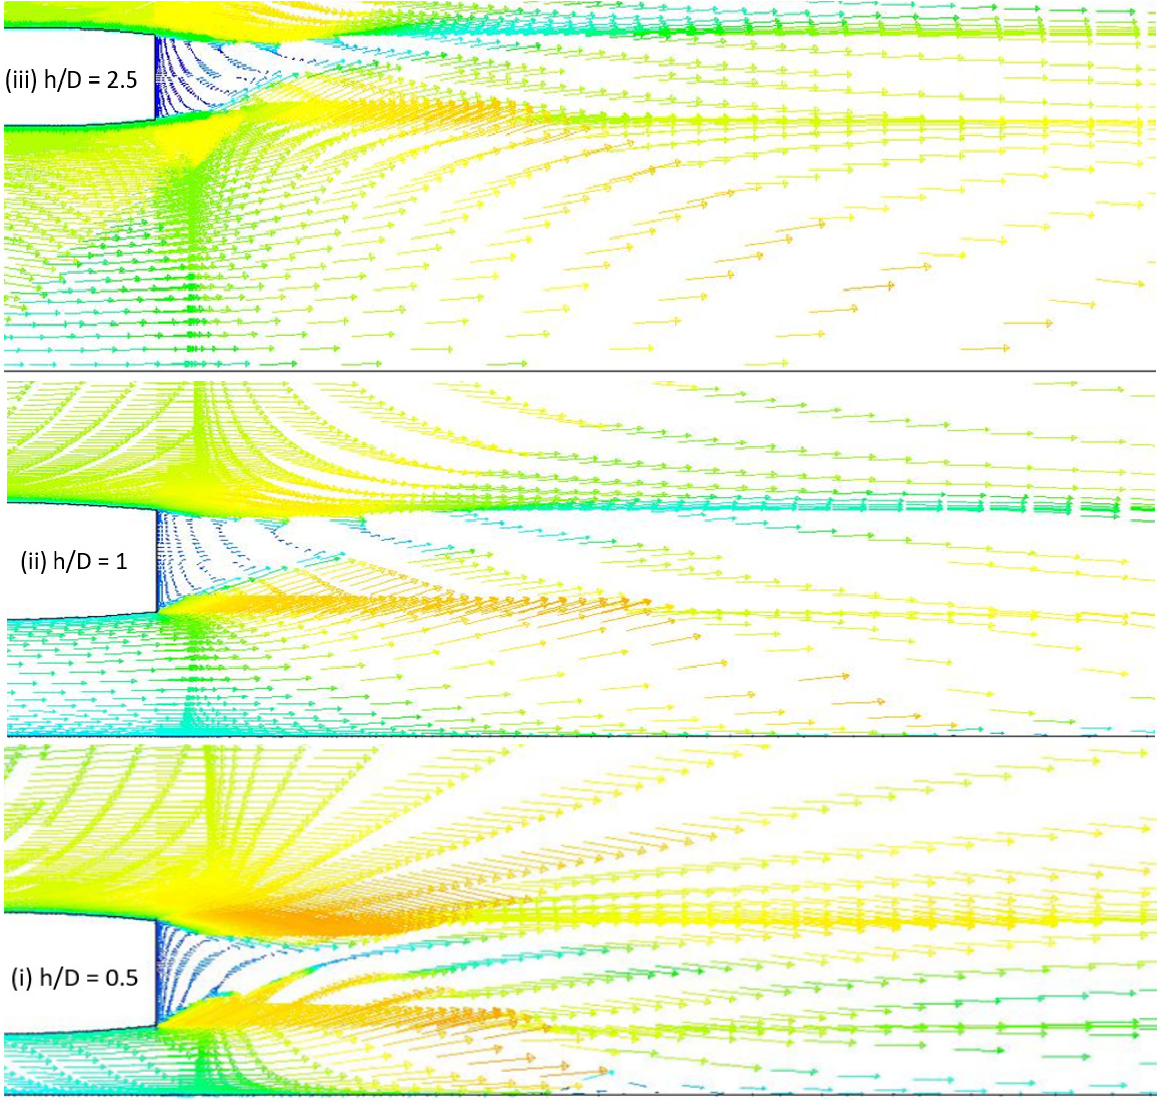
Figure 9: Vector Contours (i), (ii), and (iii) showcases the recirculation in h/D 0.5, 1, and 2.5 case,